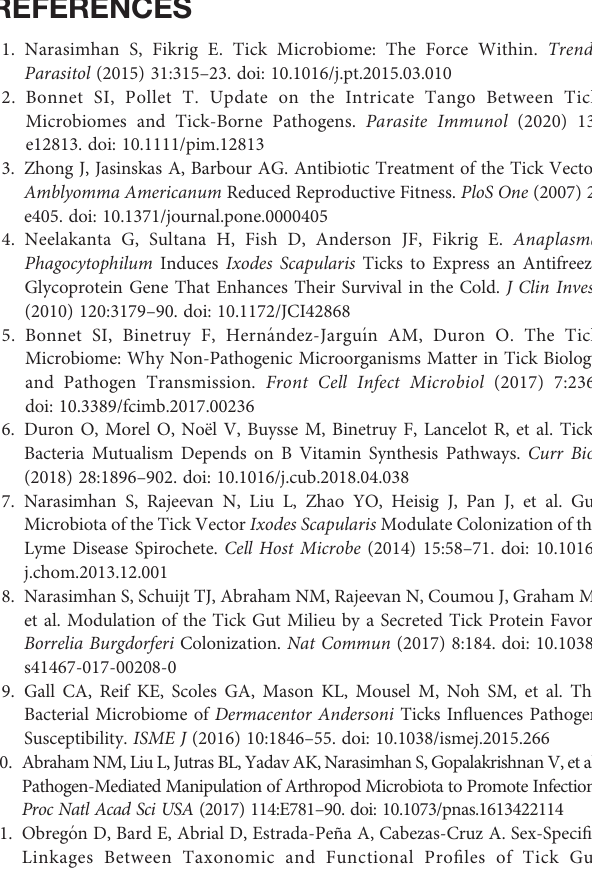
clusters of taxa that co-occur more frequently among them than with other taxa. The size of the circles is proportional to the eigencentrality of each taxon in the resulting network. Thenodes Escherichia - Shigella (red)and Leuconostoc (cyan)were identi fi ed and labelled (lighting symbol). Supplementary Table 1 | Predicted genes (KO) with differential abundance in the ticks that fed on mock-immunized mice compared to unfed ticks. Supplementary Table 2 | Predicted genes (KO) with differential abundance in the ticksthat fed on L. mesenteroides -immunized compared tomock-immunized mice. Supplementary Table 3 | Predicted genes (KO) with differential abundance in the ticks that fed on E. coli -immunized compared to mock-immunized mice. Supplementary Table 4 | Pathways with differential abundance in the ticks that fed on mock-immunized mice compared to unfed ticks. Supplementary Table 5 | Pathways with differential abundance in the ticks that fed on L. mesenteroides -immunized compared to mock-immunized mice. Supplementary Table 6 | Pathways with differential abundance in the ticks that fed on E. coli -immunized compared to mock-immunized